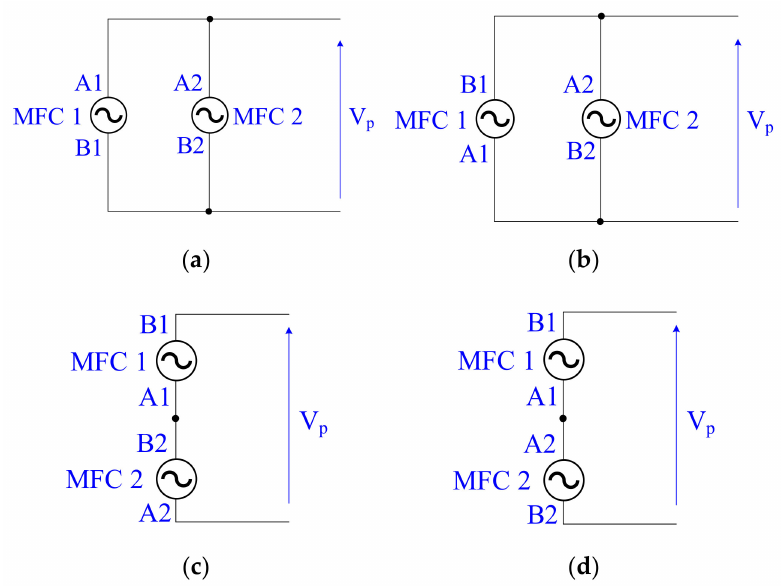
Figure 9. Connections of two MFC patches in bimorph: ( a ) parallel 1; ( b ) parallel 2; ( c ) series 1; ( d ) series 2.